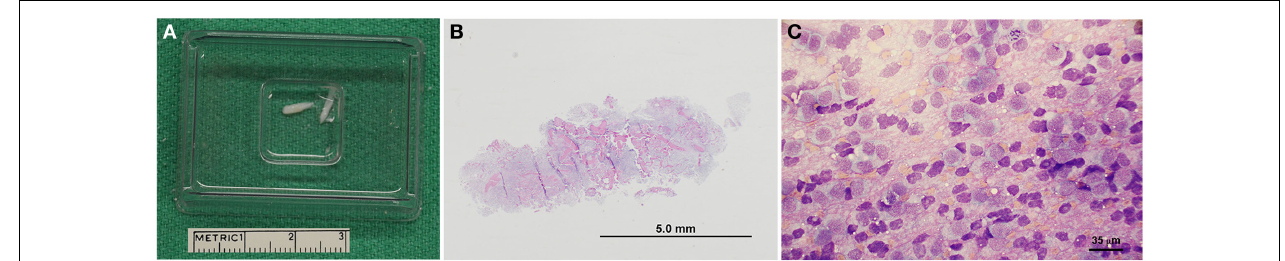
ovoid. Cells contain eccentrically or centrally located, round, ovoid, or reniform-shaped nuclei with stippled to coarsely stippled chromatin and a single to sometimes two small to medium-sized nucleoli. There are abundant bare nuclei. Cytoplasm is small to moderate in volume and basophilic and granular with distinct cytoplasmic borders; cytoplasm occasionally contains few to rarely moderate numbers of punctate